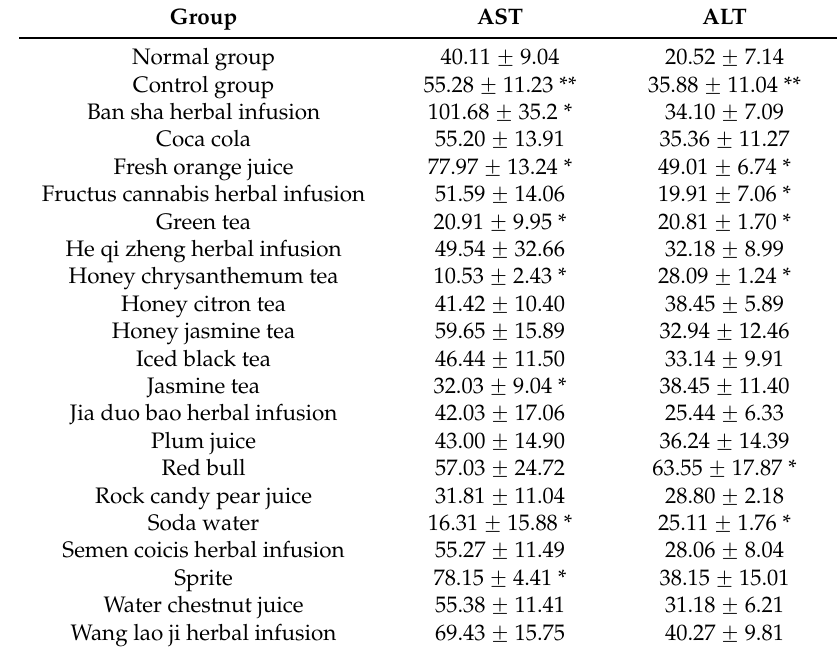
Table 3. Effects of the 20 selected beverages on serum AST and ALT activities in